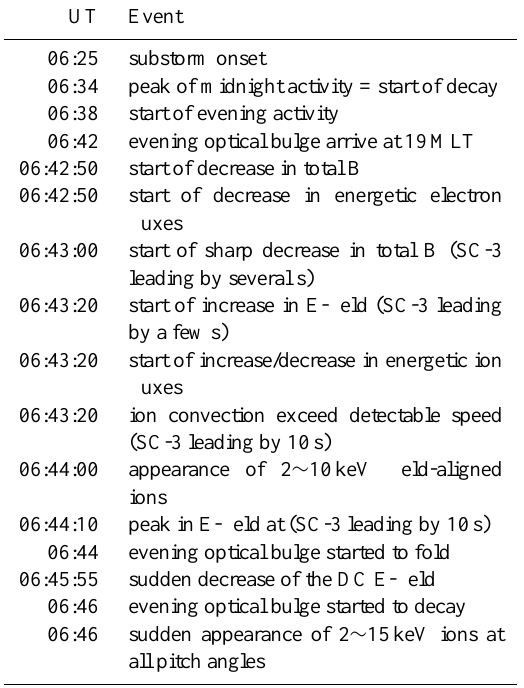
Table 1. Timeline of the